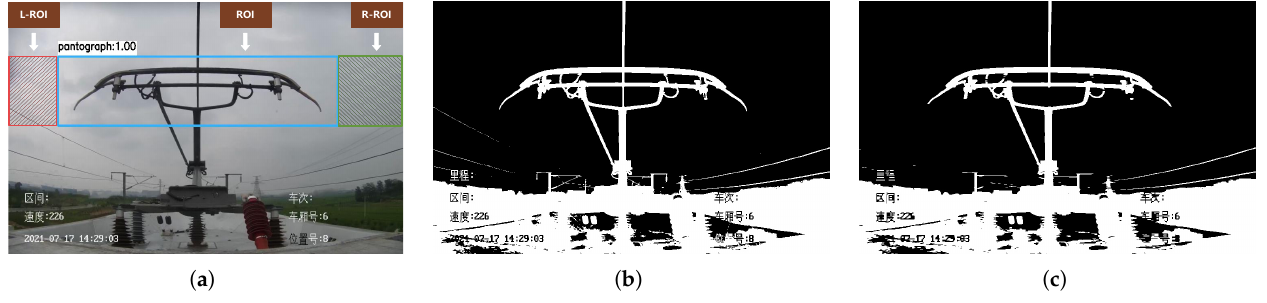
Figure 20. Image binarization and opening operations. ( a ) L-ROI, ROI and R-ROI. ( b ) Binary image. ( c ) Binary image after opening